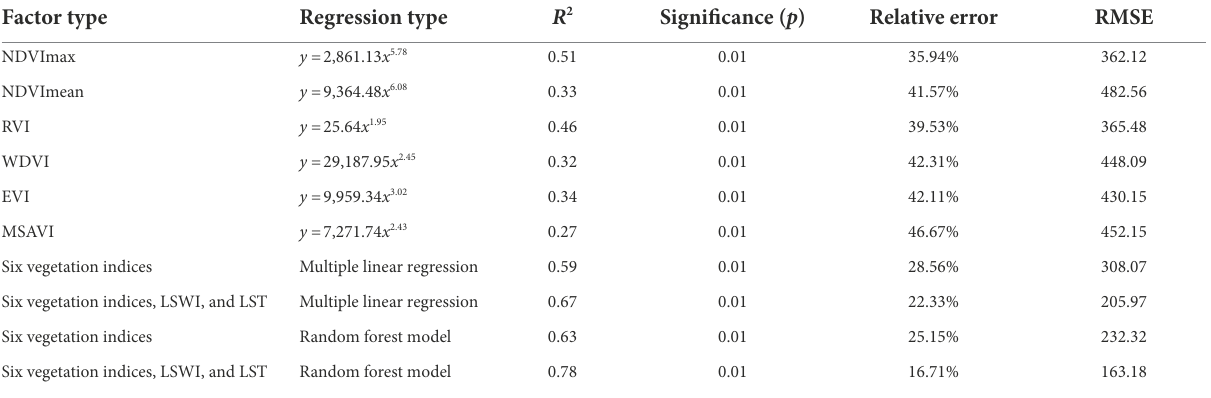
TABLE 2 Regressive results for estimating marsh aboveground biomass